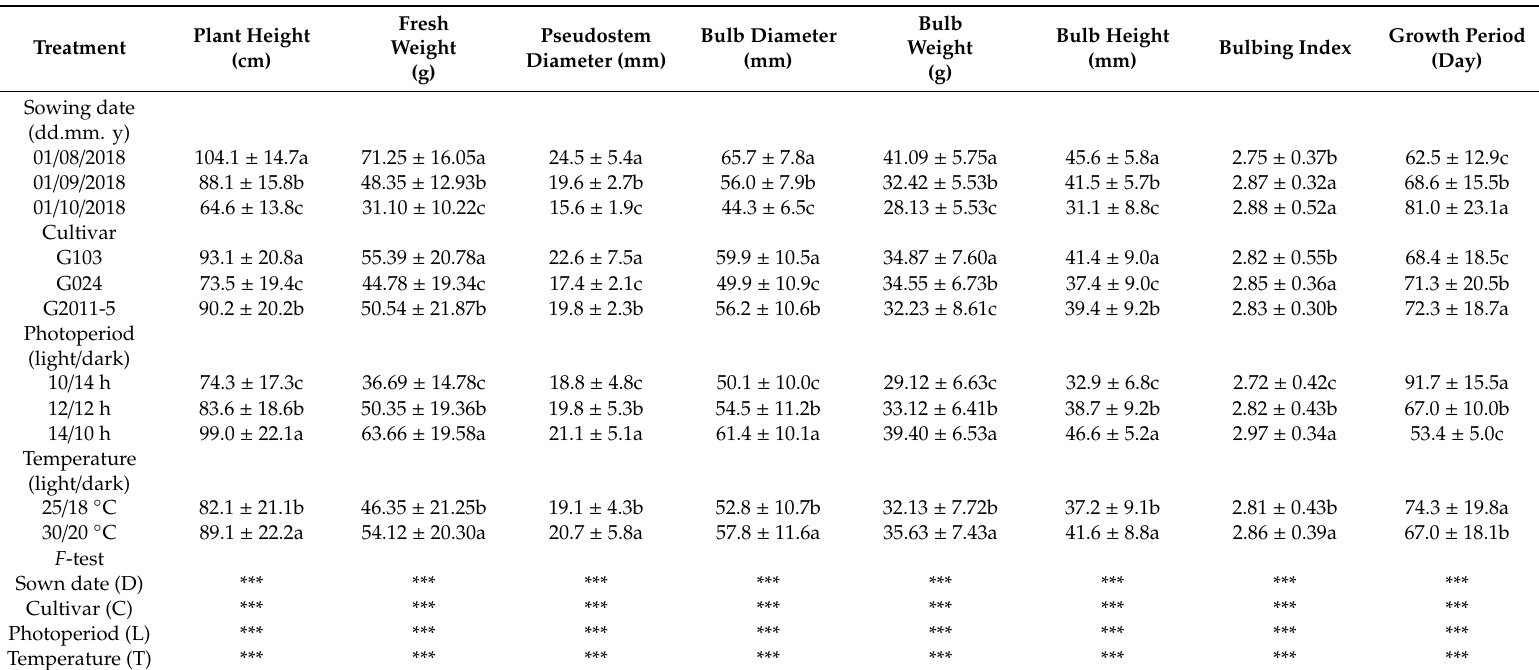
Table 1. E ff ect of sowing date, cultivar, photoperiod and temperature treatments on garlic plant morphological traits, bulb characteristics, bulbing index and growth